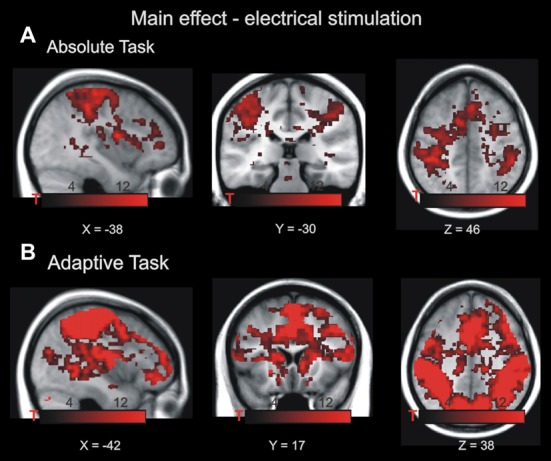
Main effect of electrical stimulation in the absolute task (A) and adaptive task (B). The highlighted voxels exhibited increased BOLD activity during noxious stimulation p < 0.001, family-wise error (FWE)-corrected at cluster level. Maps of activations are superimposed on a T1 group template. Note that both tasks require different cognitive demands; therefore, both main effects are not formally compared.